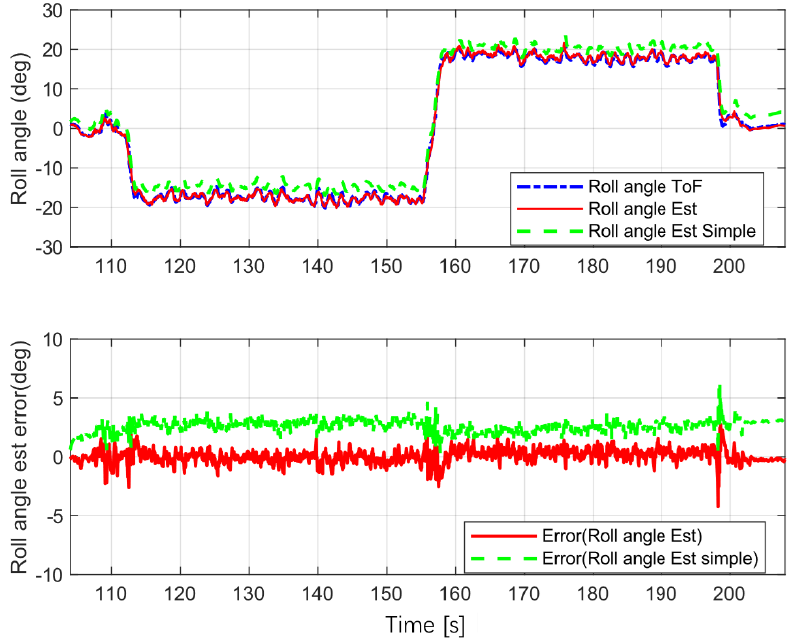
Figure 7. Steady